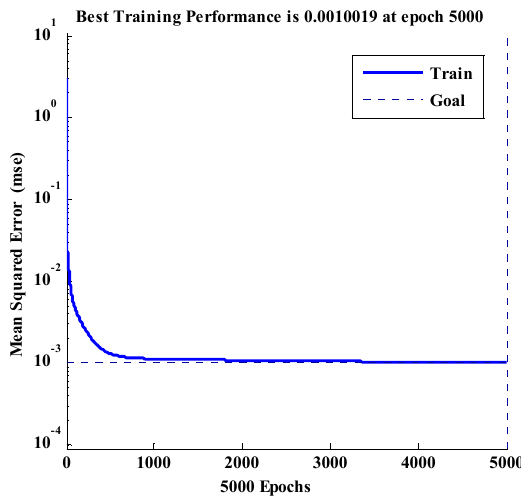
Figure 14. The training error curve.